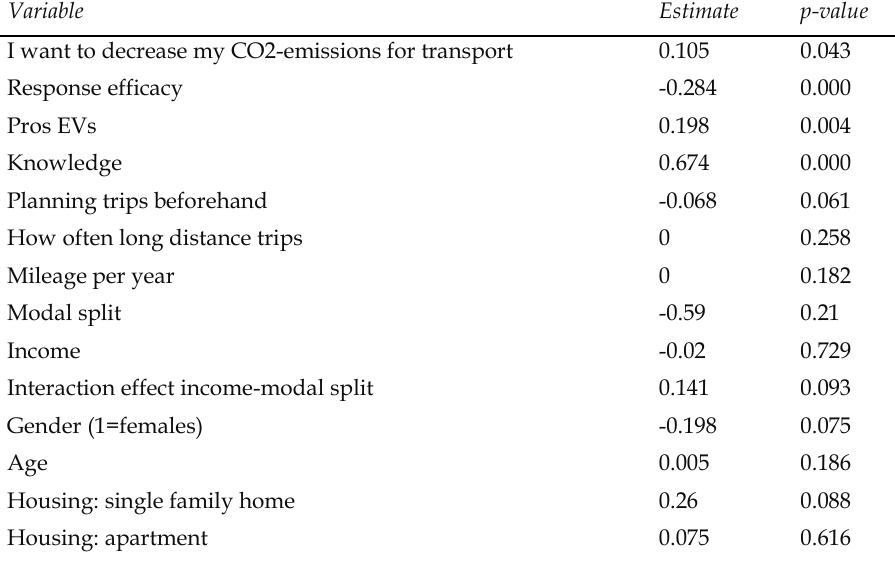
Table 7. Estimates of the structural equation of the SEM Effects on